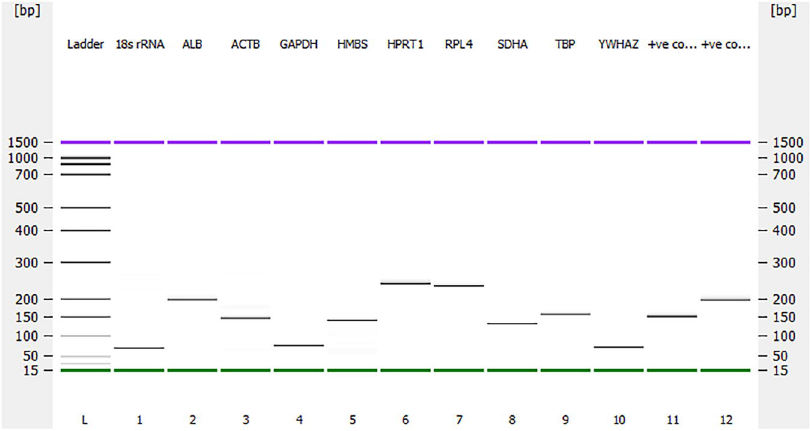
Figure 1. Amplification of the genes fragments from the shell gland tissue of chicken to assess the specificities of the primers used in the current study. (L) DNA ladder (bp); ( 1 ) 18 S rRNA (63 bp); ( 2 ) ALB (197 bp); ( 3 ) ACTB (139 bp); ( 4 ) GAPDH (66 bp); ( 5 ) HMBS (131 bp); ( 6 ) HPRT1 (245 bp); ( 7 ) RPL4 (235 bp); ( 8 ) SDHA (126 bp); ( 9 ) TBP (147 bp); ( 10 ) YWHAZ (61 bp); ( 11 ) ND4-positive control (137 bp); ( 12 ) TLR7-positive control (200 bp). The upper (purple) and lower (green) markers act as internal standards and are used to align the ladder analysis with the individual DNA sample analysis. The standard curve (plotting migration time against DNA amplicon size), in conjunction with the markers, is then used to calculate DNA fragment sizes for each well from the migration times measured (see Agilent 2100 Bioanalyzer Users Guide for Molecular Assays). The DNA gel in Agilent 2100 Bioanalyzer was performed as per manufacturer’s instructions of Agilent DNA 1000